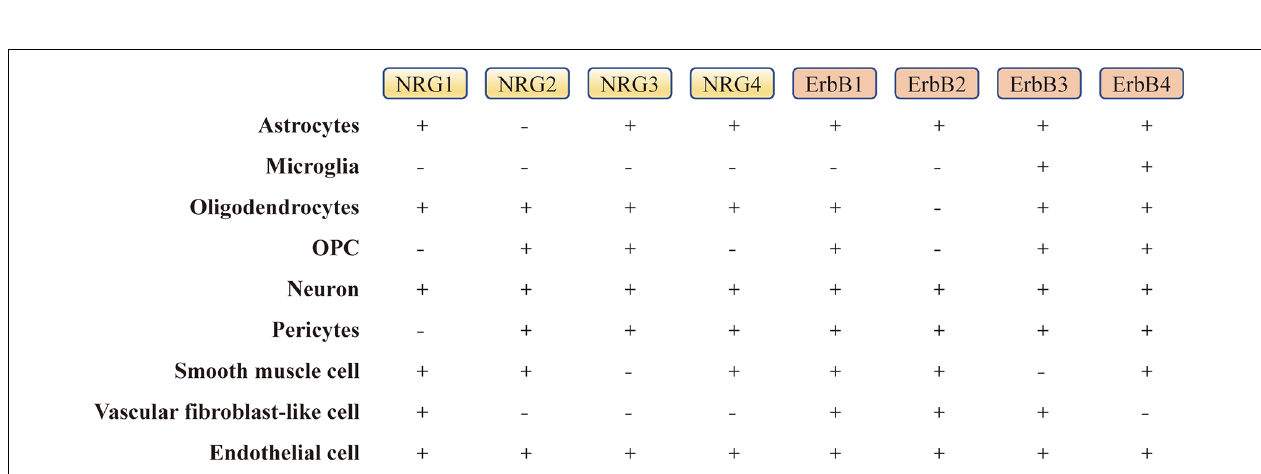
FIGURE 3 | The expression level of NRGs and their ErbB receptors in the brain. “ − ” represents the absence or low level of expression, and “+” represents the presence or high level of expression in single cells (Zhang et al., 2014; He et al., 2018; Xu et al., 2018). OPC, oligodendrocyte precursor cell.